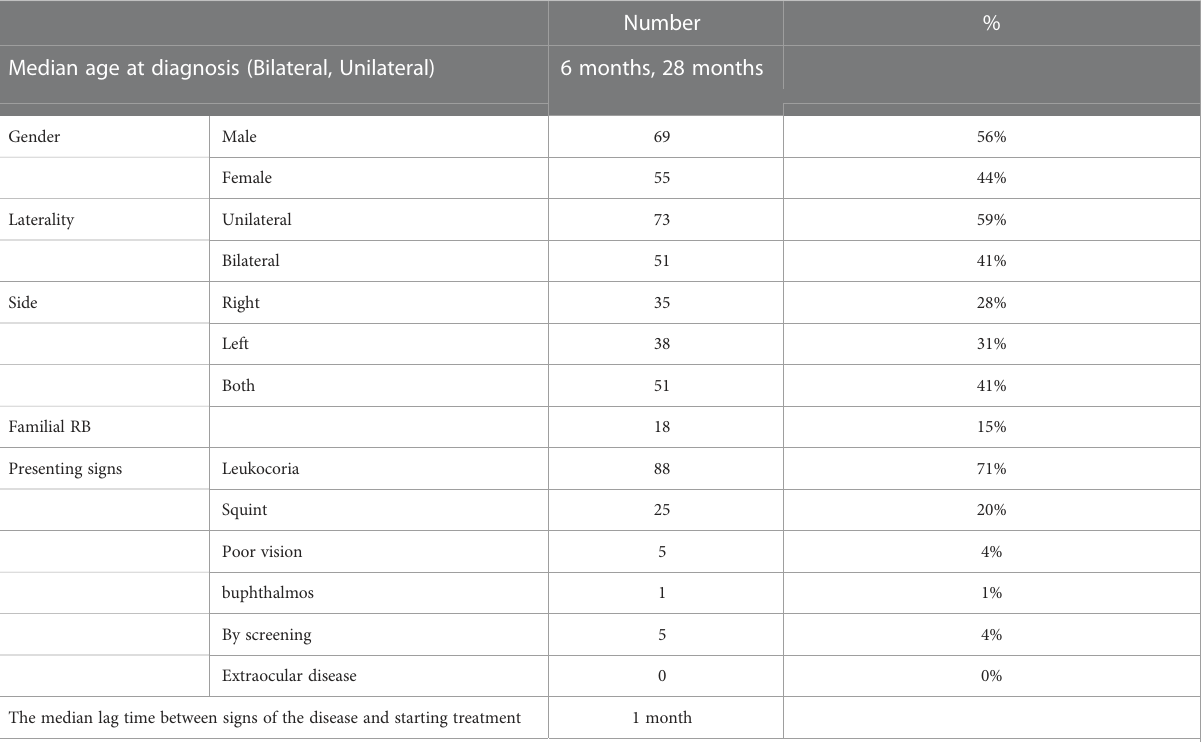
TABLE 2 Demographics, Tumor features, and management outcomes for 124 Jordanian patients with retinoblastoma treated between 2011-